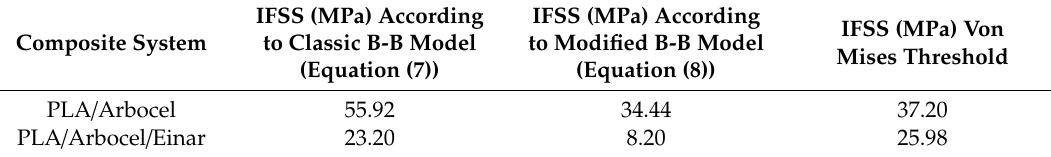
Table 5. IFSS evaluation for PLA/Arbocel composites with and without Einar.